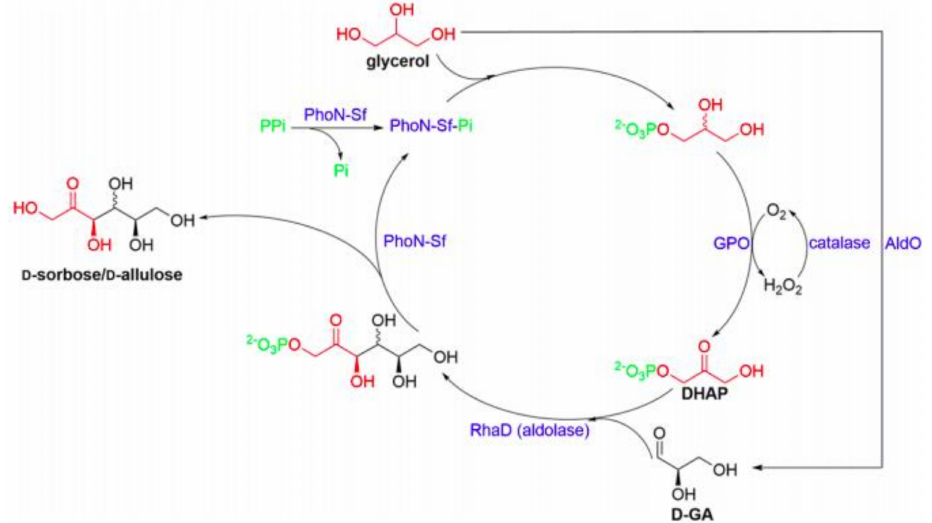
Figure 2. Multi-enzyme synthesis of D-sorbose / D-allulose from glycerol. PPi: pyrophosphate, Pi: inorganic phosphate. Reprinted with permission from Ref. [30]. Copyright © 2020 American Chemical